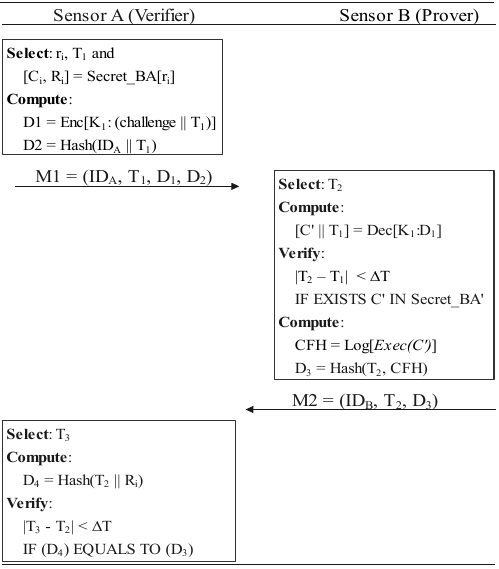
Figure 9. The verification phase.